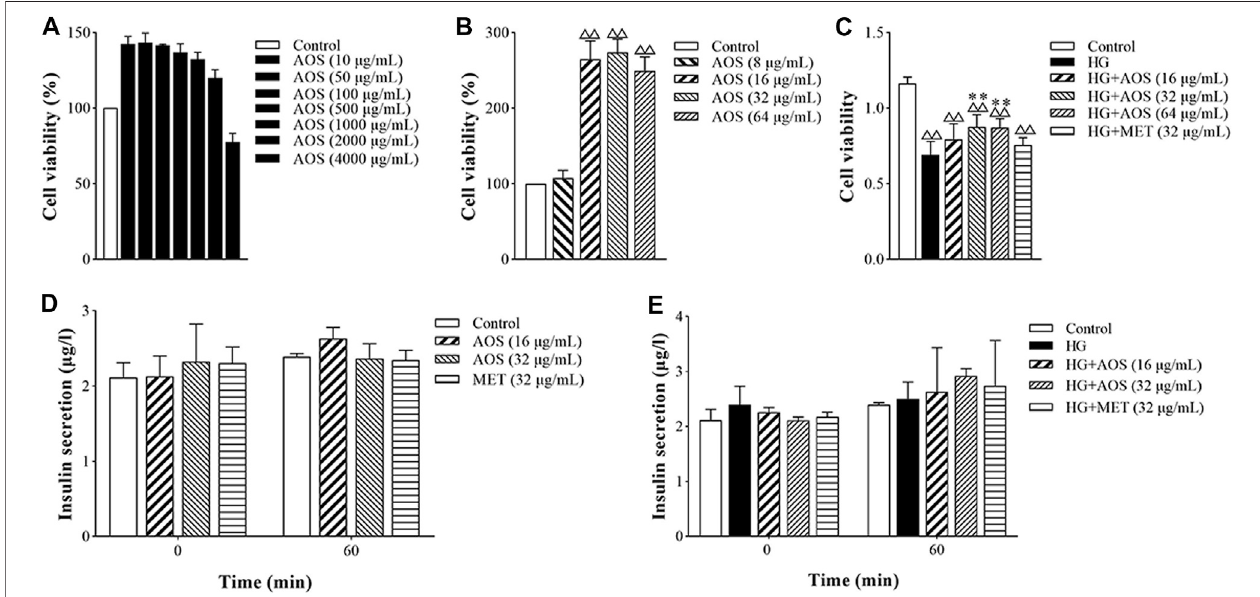
FIGURE5| AOSimproved theproliferationofpancreatic MIN6cells. (A) MIN6cellswerecultured and treatedwith differentconcentrations ofAOS(0, 10,50, 100, 500, 1,000, 2000, and 4,000 μ g/ml) for 24 h △△ p < 0.01 versus control (0 μ g/ml) group. (B) MIN6 cells were treated with different concentrations of AOS (0, 8, 16, 32, and 64 μ g/ml) for 24 h. (C) MIN6cells were incubated with normal glucose(5.5 mM)or high glucose (33.3 mM)for 24 h, and then thecells were cultured in the absence or presence of AOS with different concentrations (16, 32, and 64 μ g/ml) for 24 h △△ p < 0.01 versus control (0 μ g/ml) group; ** p < 0.01 versus the high-glucose group. (D) The insulin levels after incubation with AOS for 1 h. (E) The insulin levels after incubation with glucose for 1 h.